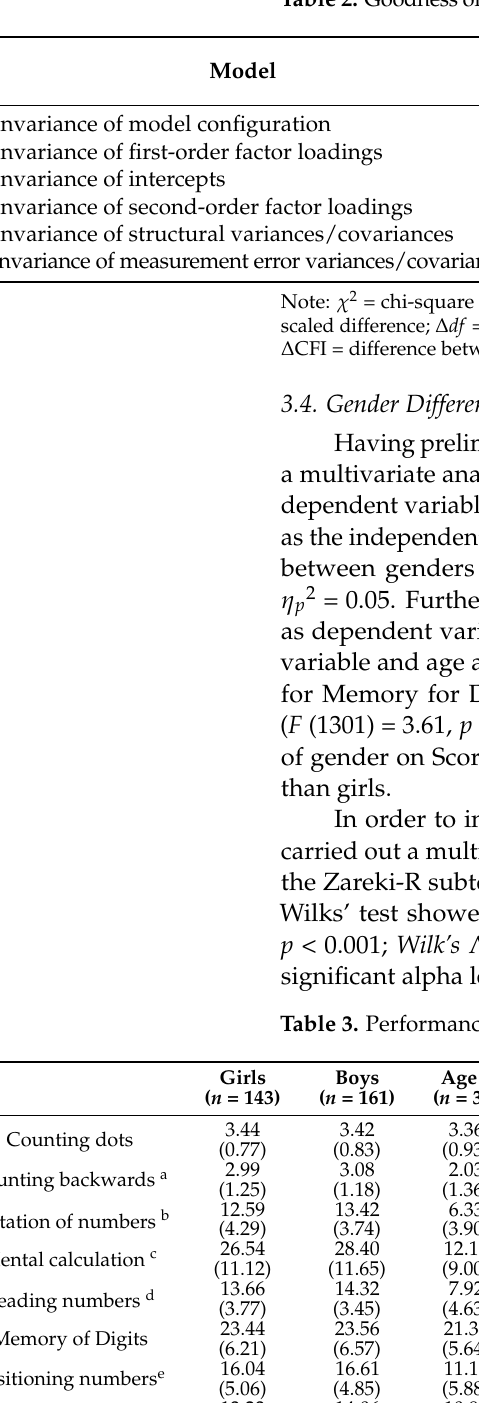
Table 2. Goodness of fit statistics for each level of structural and measurement invariance across genders.